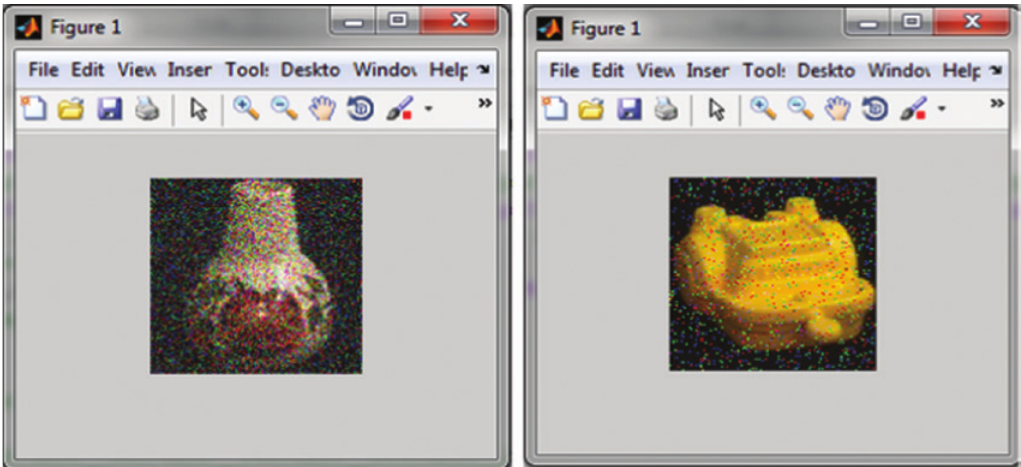
Figure 9: Image with Additive Gaussian Noise and Salt and Pepper